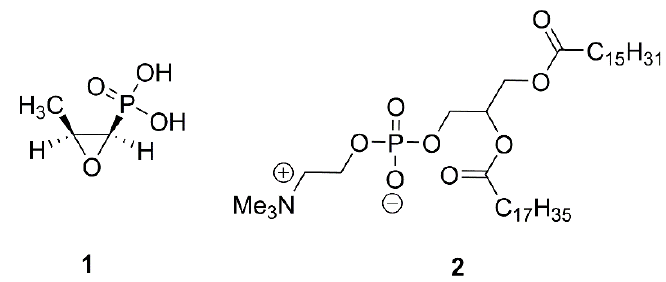
Figure 1. Structures of Fosfomycin 1 and Phosphatidylcholine 2 .